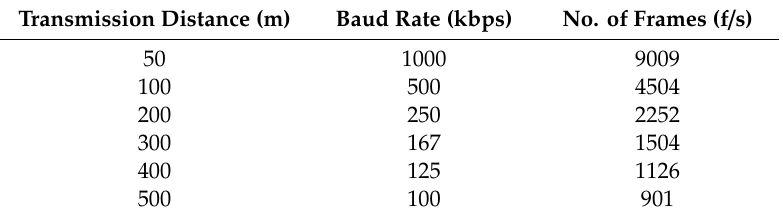
Table 1. Baud rates with distance of